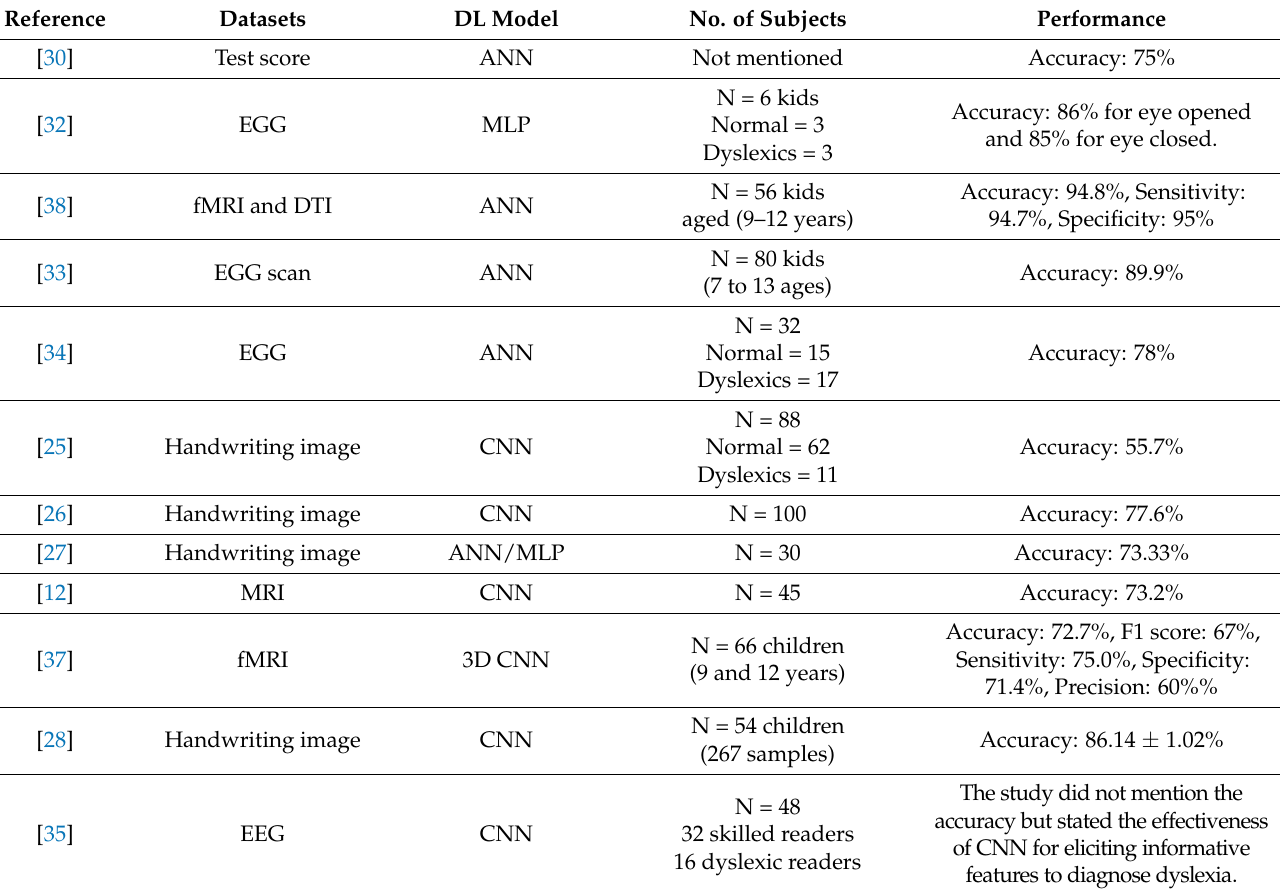
Table 3. Summarizes the performance of the predictive model of each study in this